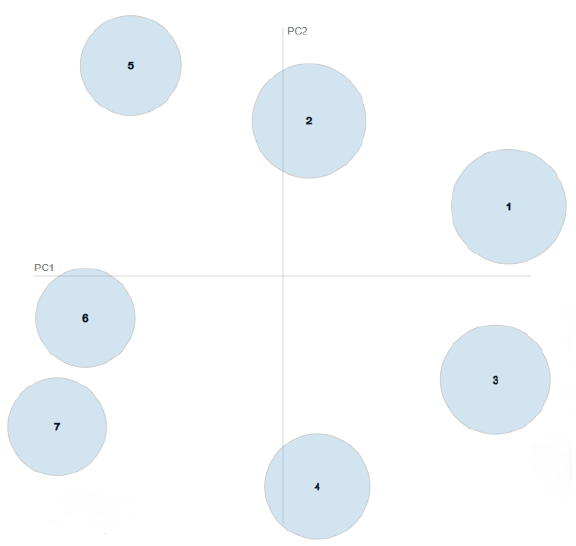
Figure 7. Topic modeling